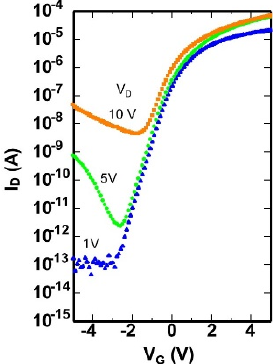
Figure 10. Drain current I D versus gate voltage V G characteristics as a function of the drain voltage V D . Parallel TFT. μ ‖ = 710 cm 2 /Vs.